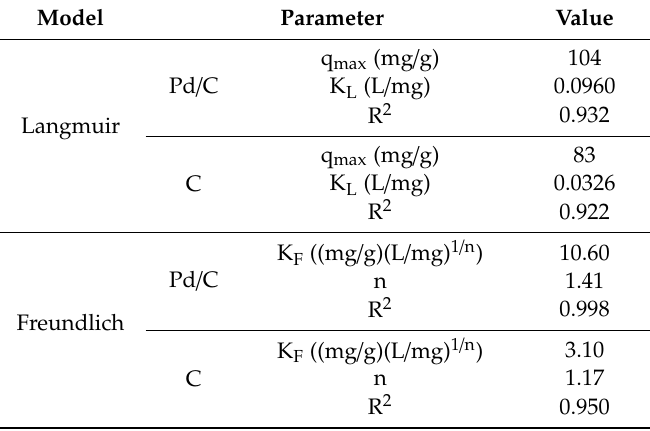
Table 1. The adsorption isotherm parameters for MO adsorption according to the linear Langmuir and Freundlich models.